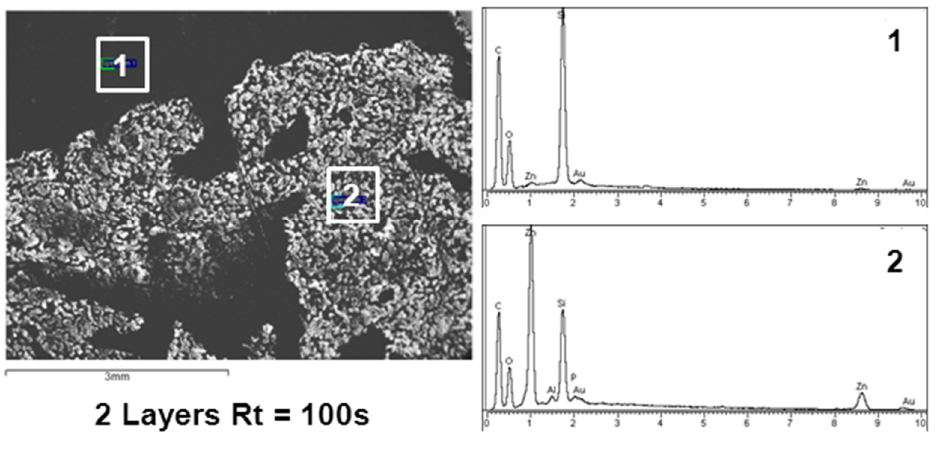
Figure 3. SEM image of HDGS coated with two layers (Rt = 100 s) of U(400). (1) and (2) represent the EDS analysis obtained in two distinct areas, which are indicated in the SEM